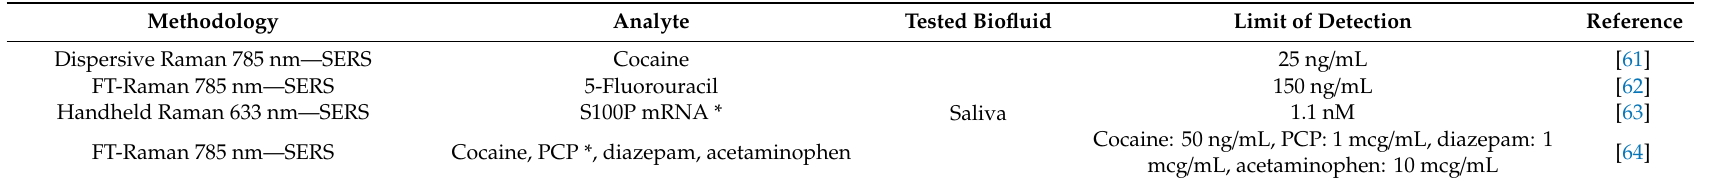
Table 3. Overview of the analytes detected from biofluids using Raman and FT-IR